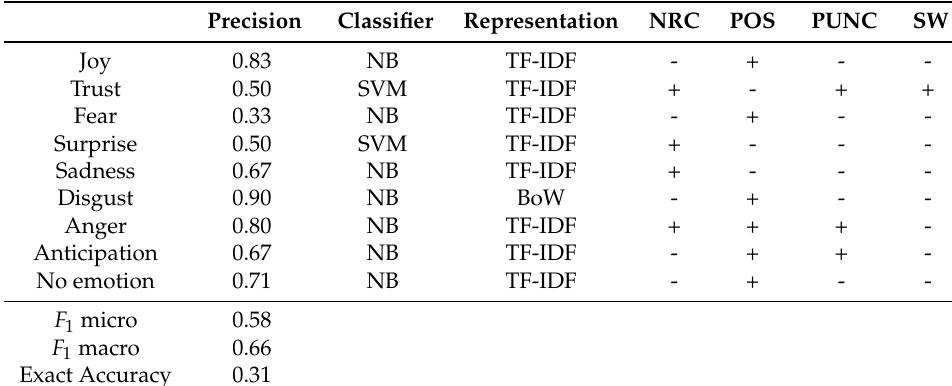
Table 13. Ensemble of binary classifiers. NB: Multi-nominal Naive Bayes, SVM: Support